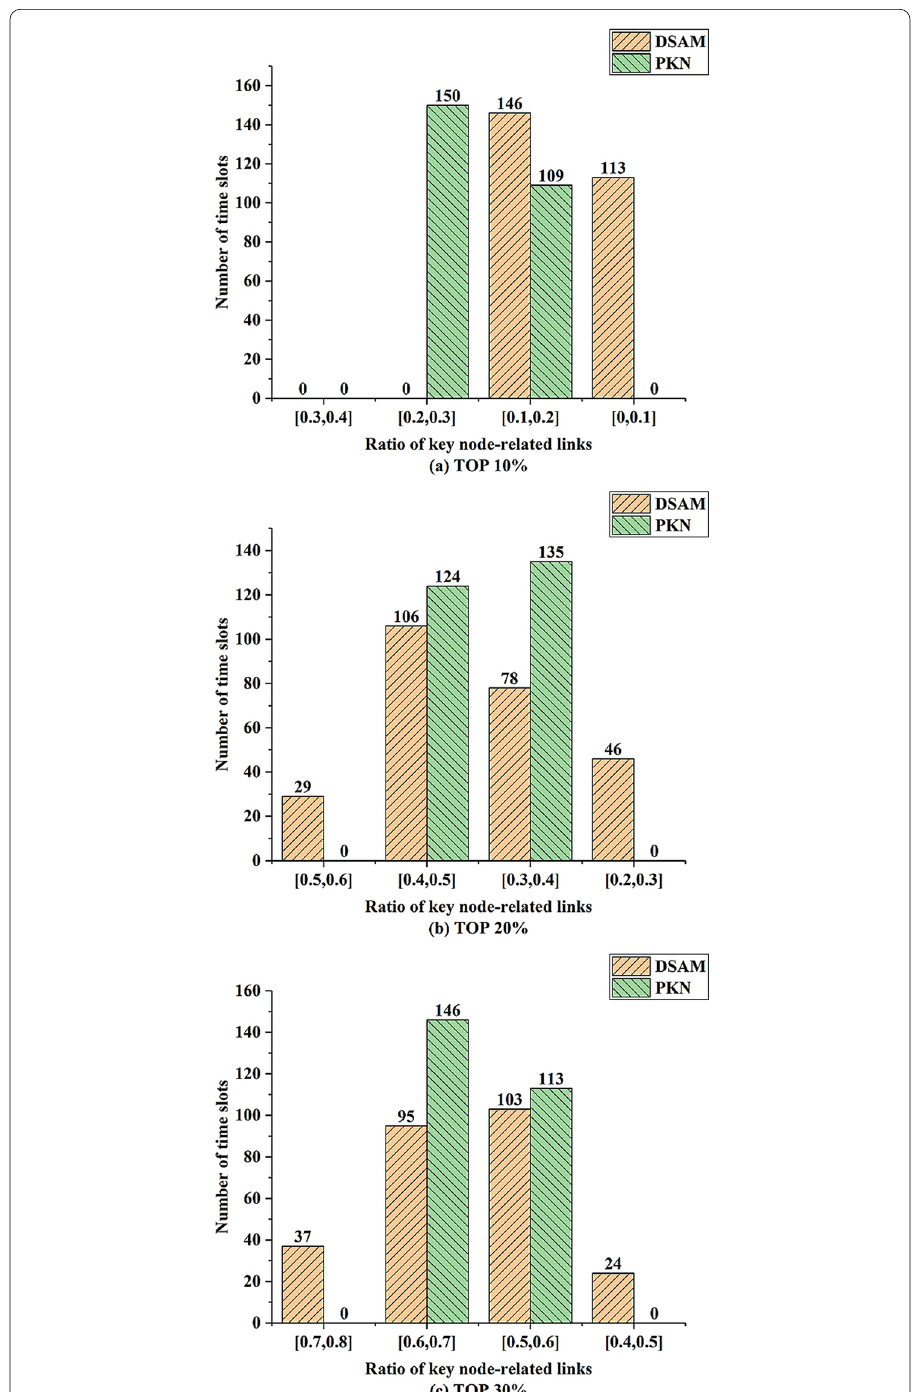
Fig. 7 The ratio of key node related links in each time slot in